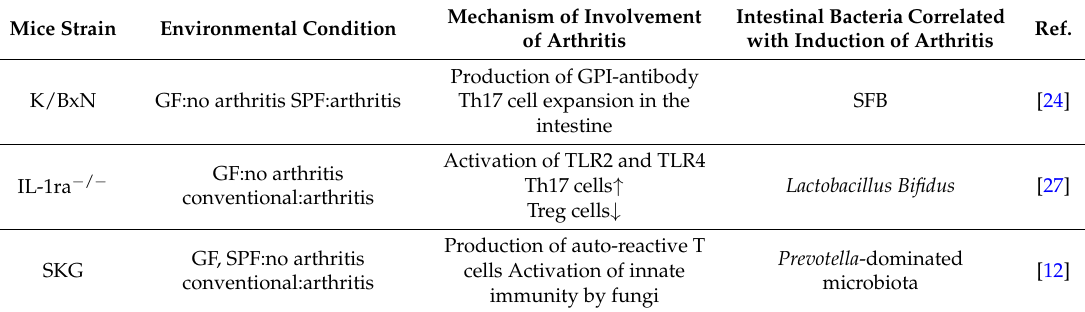
Table 1. Animal models of arthritis known to be correlated with intestinal bacteria.